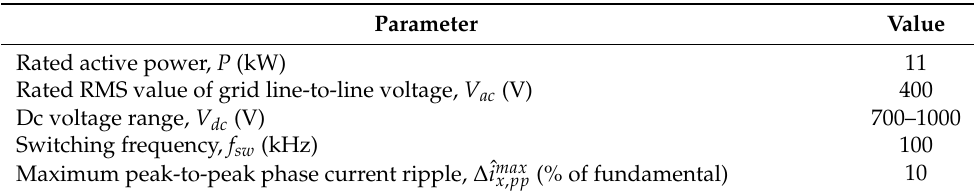
Table 3. Design parameters of the three-phase power factor correction (PFC) stage of an on-board charger